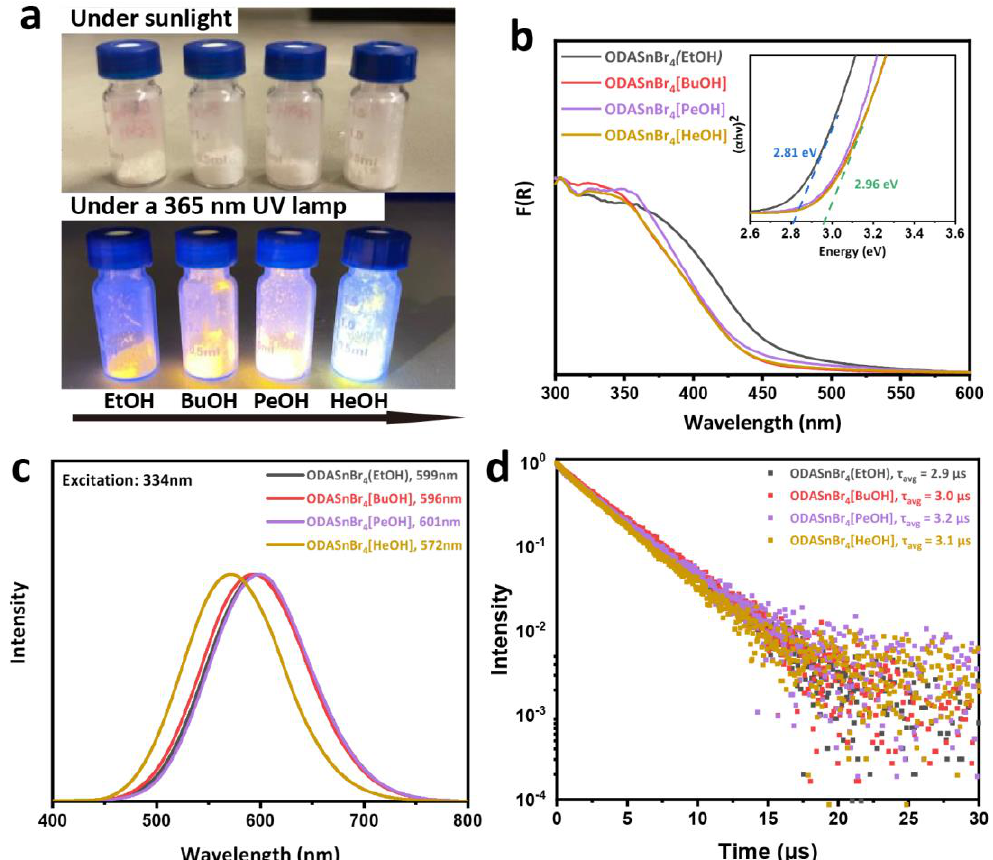
Figure 2. ( a ) Photograph of the ODASnBr 4 (EtOH), ODASnBr 4 [BuOH], ODASnBr 4 [PeOH], and ODASnBr 4 [HeOH] perovskite microcrystals taken under sunlight and under a 365 nm UV lamp; ( b ) absorption spectra represented by Kubelka – Munk function, F(R); the inset shows the corresponding Tauc plots used to determine the optical bandgaps, ( c ) normalized PL spectra, and ( d ) normalized PL decay curves of these four samples.